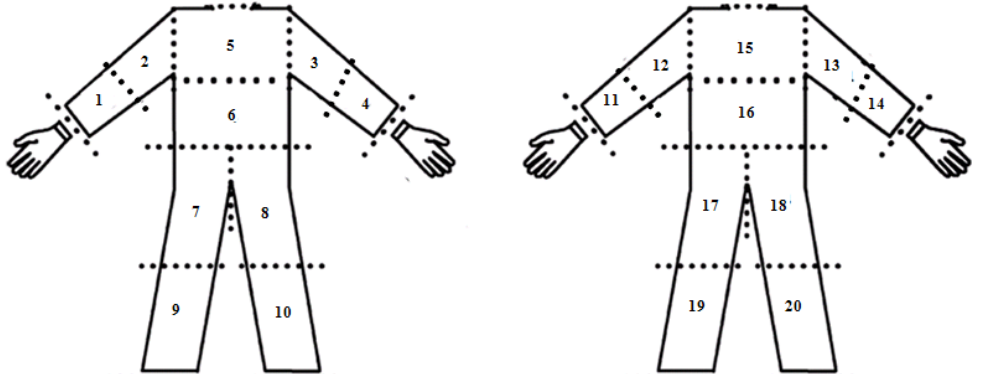
Figure 3. Tyvek ® cutting scheme (adapted from